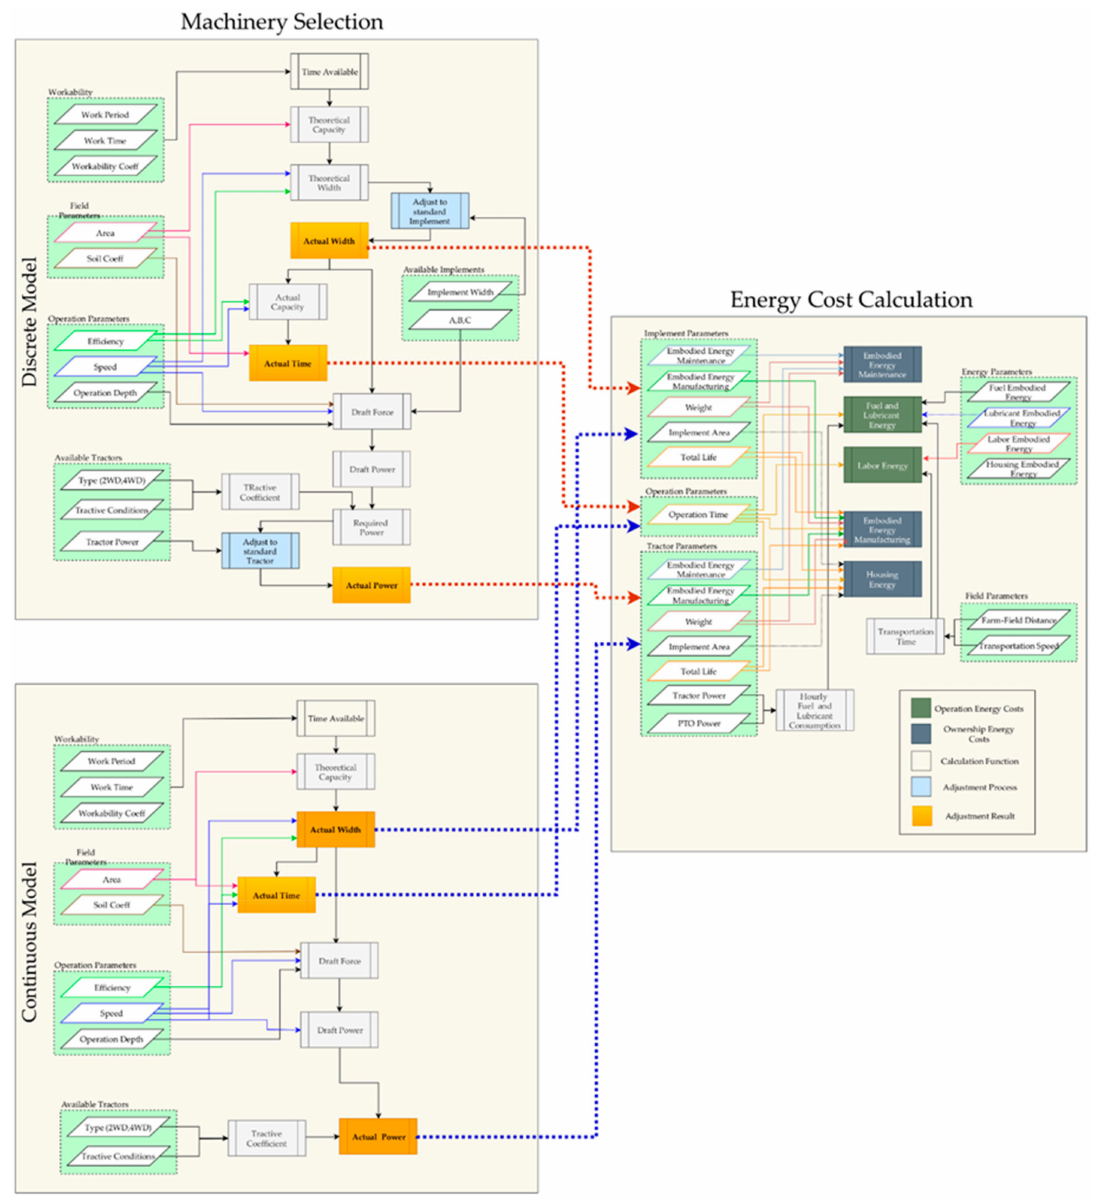
Figure 2. Calculation